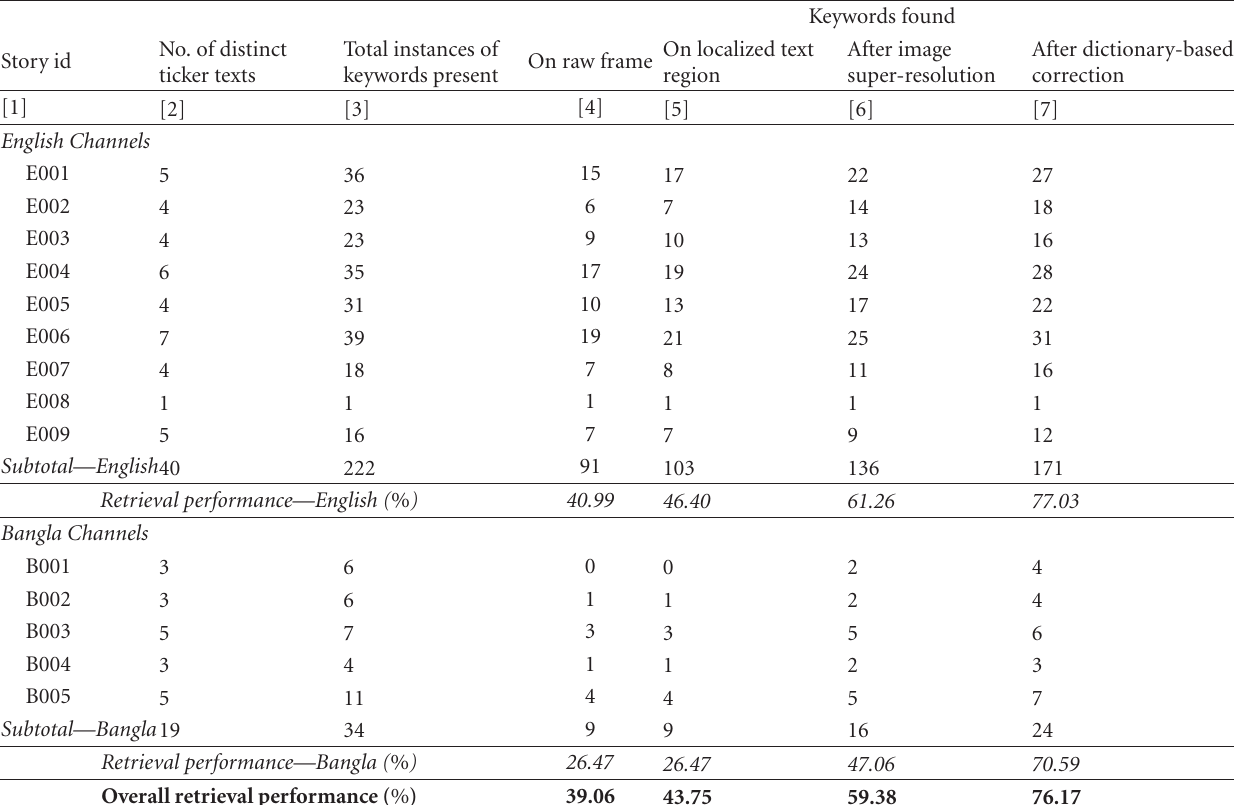
Table 4: Results for keyword spotting in ticker text with constrained keyword